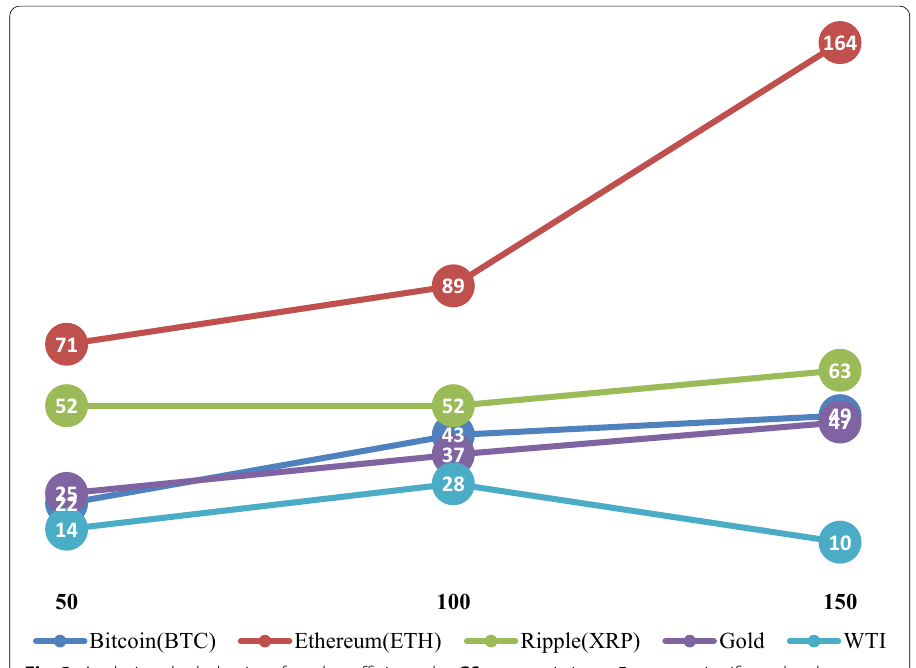
Fig. 3 Analyzing the behavior of market efficiency by GS tests statistics at 5 percent significant level